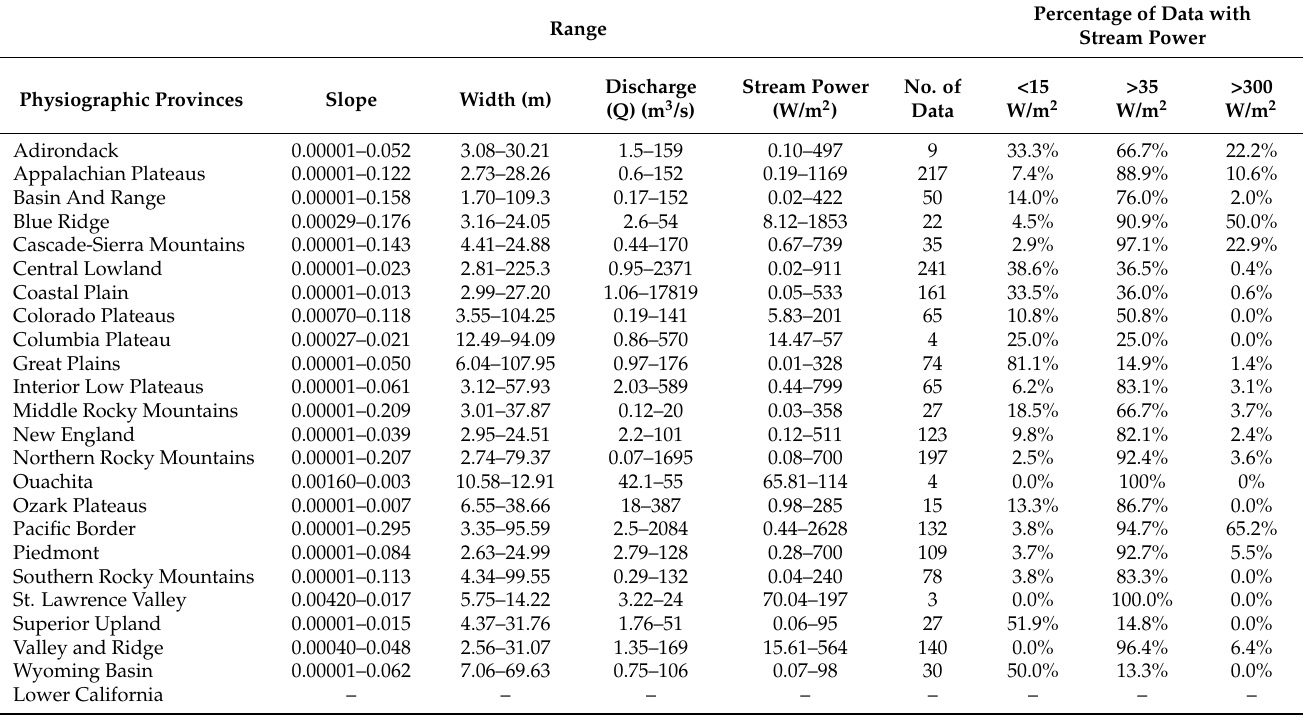
Table 2. Number of sites, range of parameters, and stream power with the percentage of data points above or below power thresholds per Physiographic